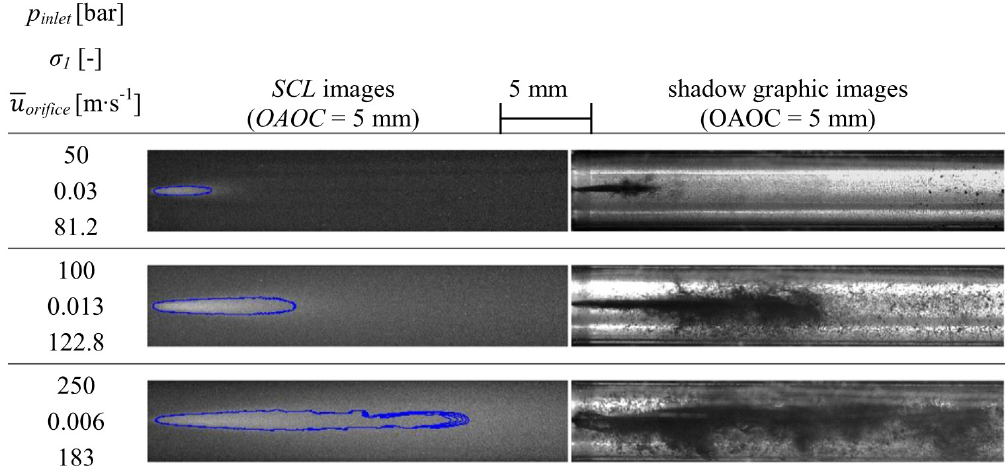
Figure 7. Comparison between SCL images and visualized cavitation pattern via shadow graphic imaging at different inlet pressures p inlet . Experiments were conducted without back-pressure ( p outlet = 1 bar). Reproduced with the permission from [41]; Elsevier, 2016.